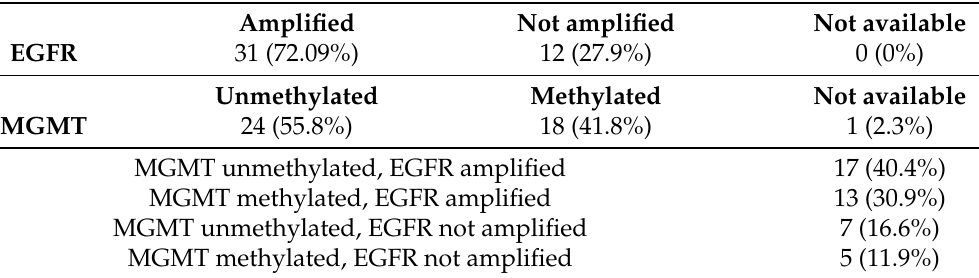
Table 2. Number of patients in each